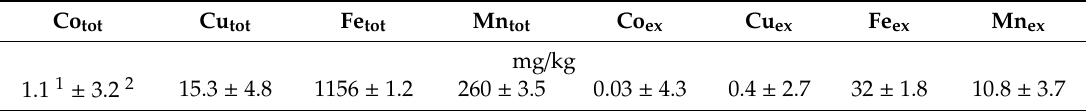
Table 4. Total and exchangeable forms of metals in wheat straw biochar. Co